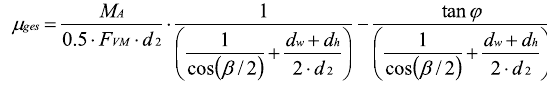
Fig. 4 Formula for the coefficient of